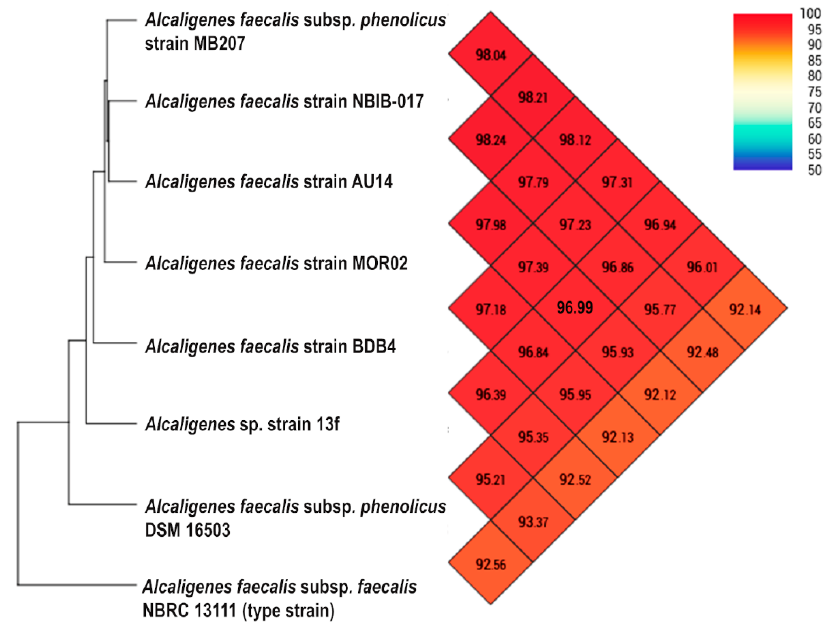
Figure 3. A heatmap presenting the ANI values of Alcaligenes sp. strain 13f and seven closely related strains, including the type strain ( Alcaligenes faecalis subsp. faecalis NBRC 13111). The heatmap was calculated by using the Orthologous Average Nucleotide Identity Tool (OAT) software.